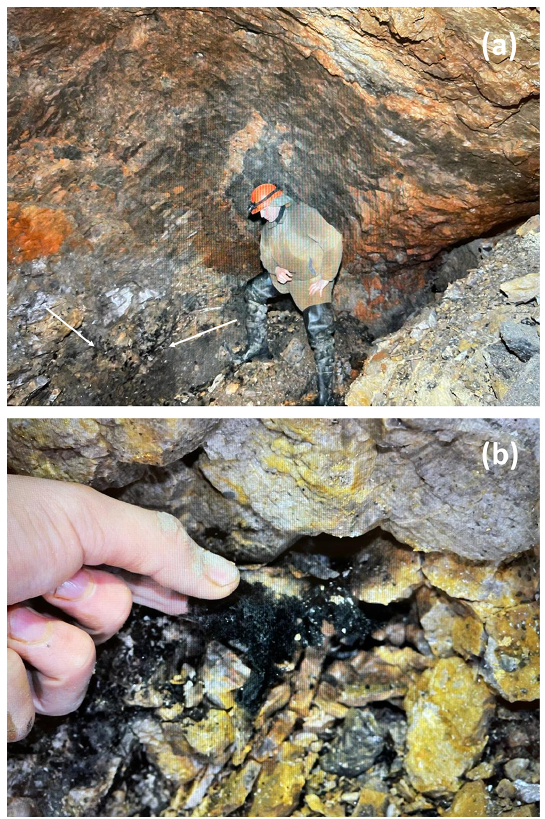
Figure 2. (a) Kerite-rich in situ occurrence (black; arrows) on wall inside crystal cavity chamber in shaft 3 of Volyn Cham- ber Pegmatite, Volyn Piezo Quartz Deposit, Korosten Pluton, Zhitomirskaya Oblast, Ukraine, with chief geologist Vsevolod Chournousenko as scale. (b) Black kerite in situ on wall inside crys- tal cavity chamber. Photos courtesy of Vsevolod